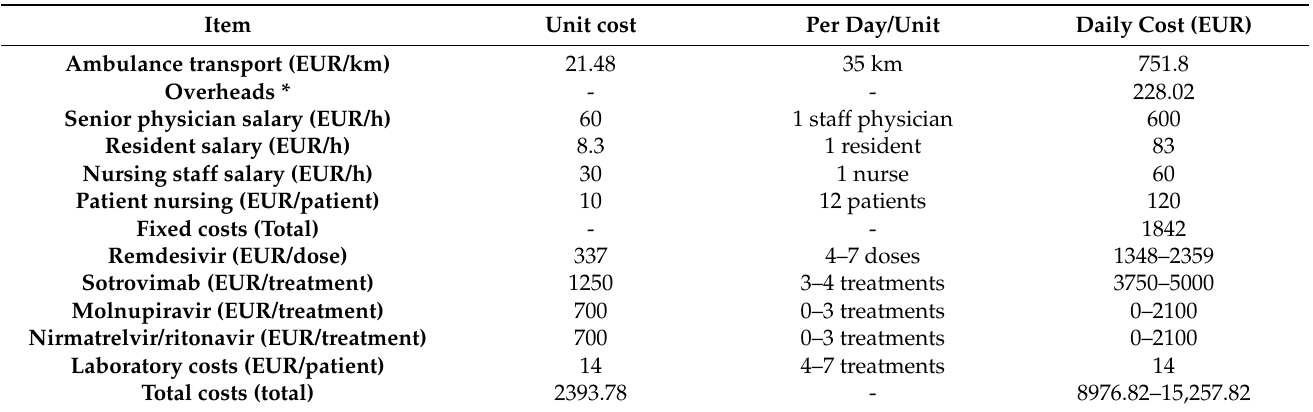
Table 1. The daily costs faced by our COVID-19 outpatient service. Costs of drugs employed for treatment vary depending on the number of treatments allocated to